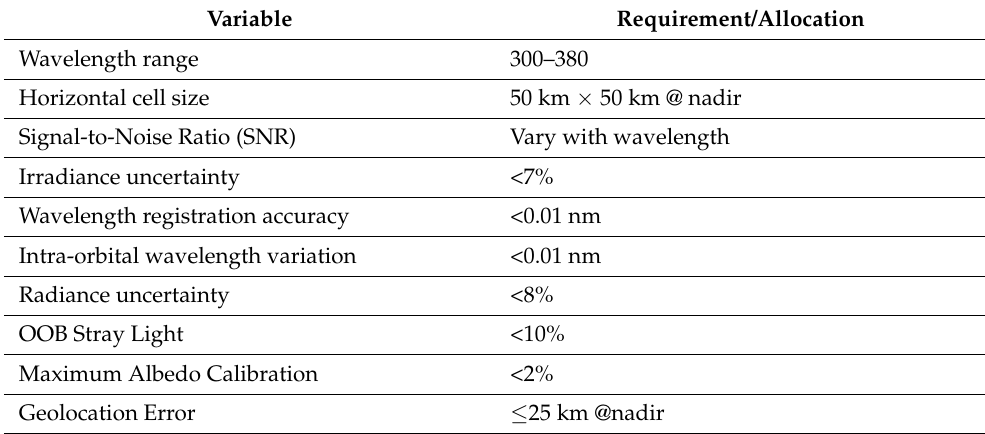
Table A3. SNPP OMPS NM SDR requirements or